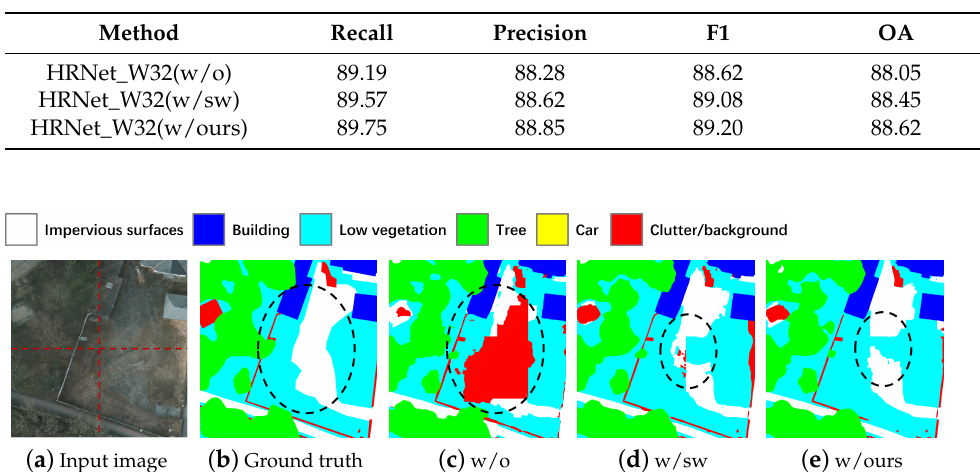
Table 3. The results evaluated by Recall (%), Precision (%), F1 (%) and overall accuracy (OA; %) based on HRNet_W32 on the Potsdam datasets.